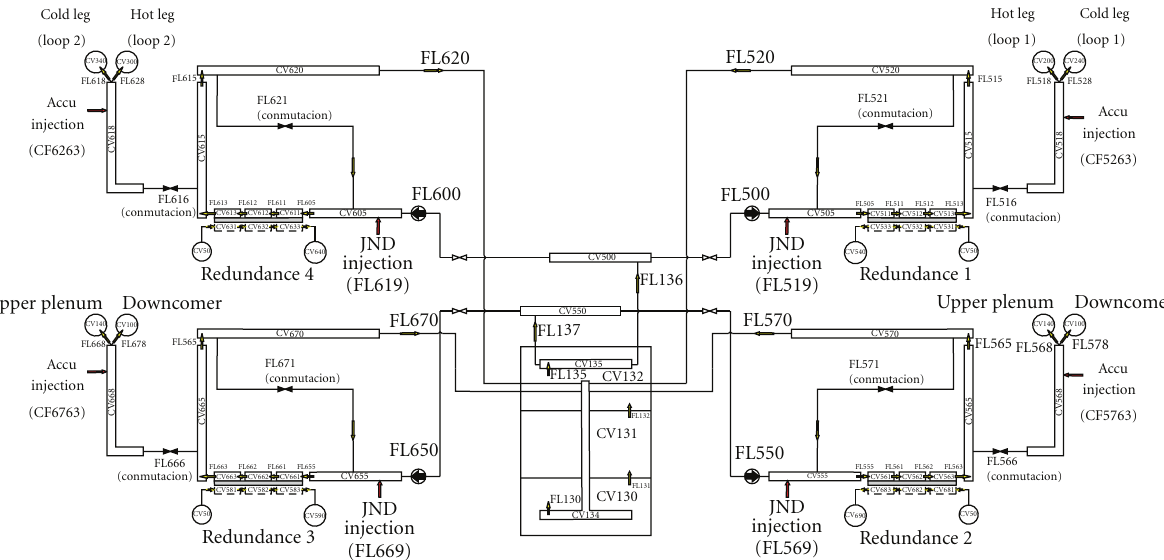
Figure 8: MELCOR nodalisation scheme of moderator systems 10 to 40.